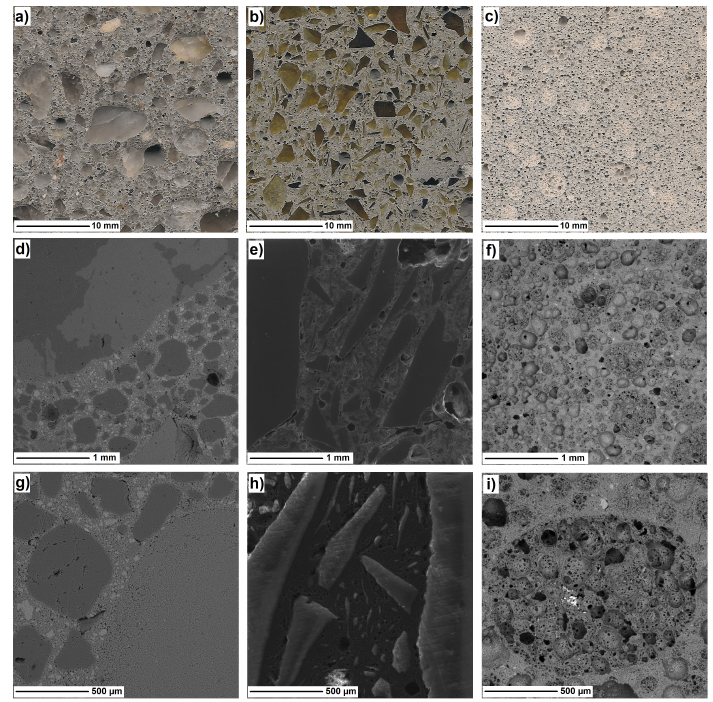
Figure7. Scannedimagesofthesamplesurfaces: (a)NS,(b)CG,(c)EG;SEMmicrographs: (d)and(g) NS,(e)and(h)CG,(f)and(i)EG Figure 7. Scanned images of the sample surfaces: ( a ) NS; ( b ) CG; ( c ) EG; SEM micrographs: ( d , g ) NS; VersionNovember16,2017submittedto Materials ( e , h ) CG; ( f , i ) EG